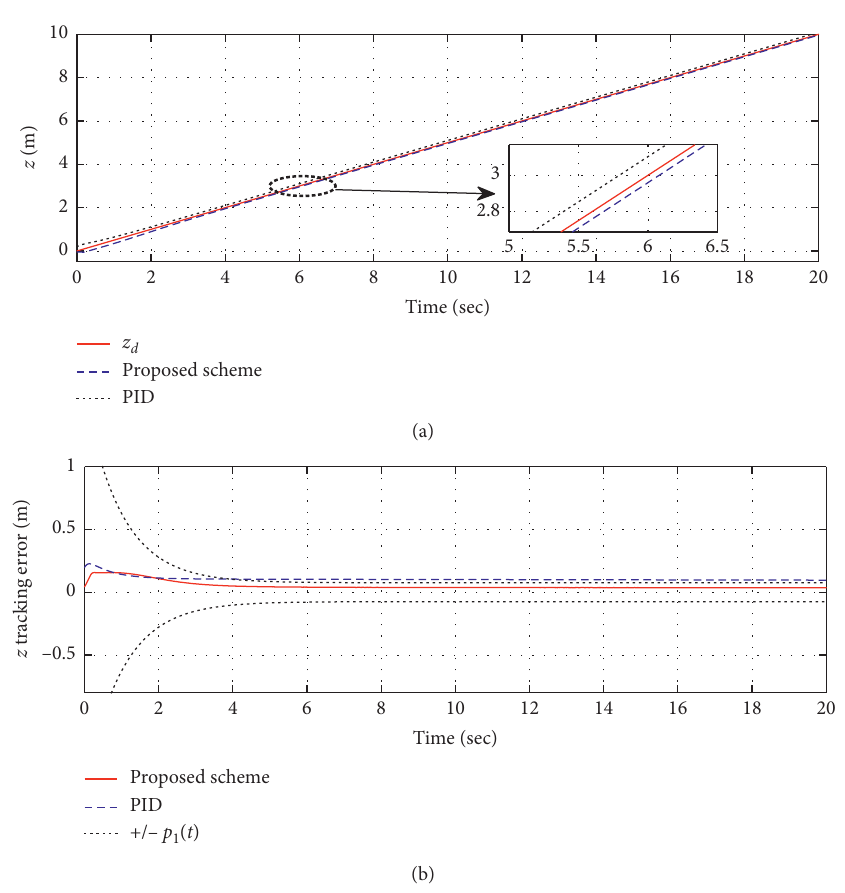
Figure 8: The tracking trajectory of z